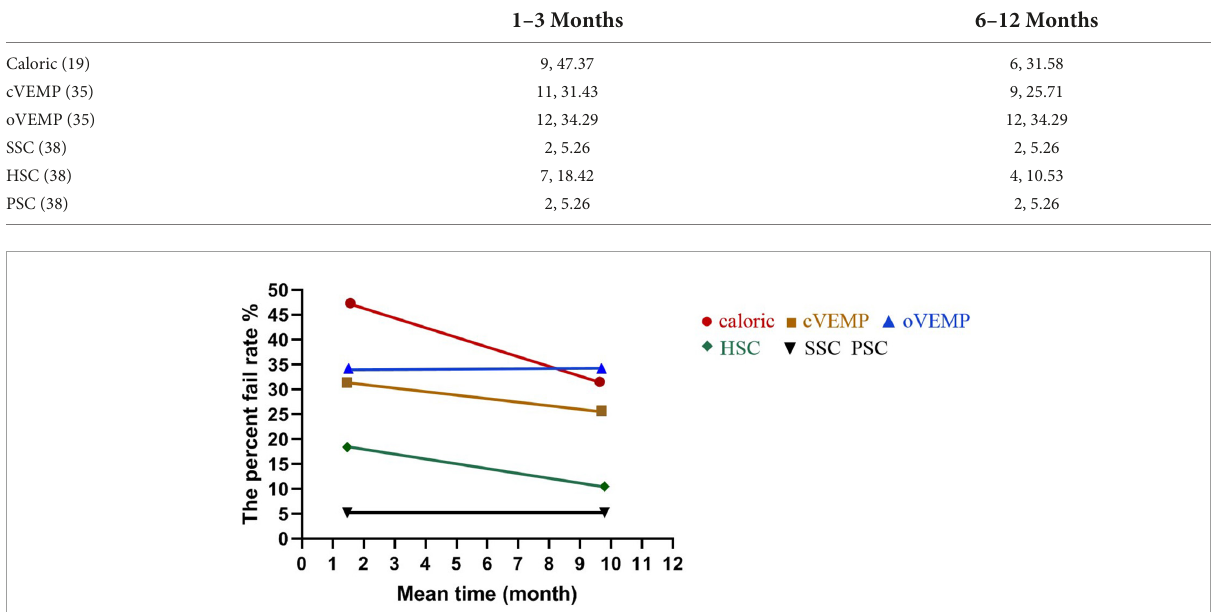
FIGURE3 The percent fail rate of each end-organ function on the implanted side at short and long follow-up times after surgery. The percent fail rates showed no significant differences from 1–3 (1.57 ± 0.90) to 6–12 (9.63 ± 2.36) months in caloric ( p = 0.319) and from 1–3 (1.47 ± 0.86) to 6–12 (9.79 ± 2.28) months in HSC tested by vHIT ( p = 0.328) post-operatively. There was no significant difference in cVEMP between 1–3 (1.46 ± 0.85) and 6–12 (9.69 ± 2.31) months ( p = 0.597). The percent fail rates of oVEMP were the same at 1–3 (1.51 ± 0.89) and 6–12 (9.69 ± 2.31) months ( p = 1.000). The percent fail rates of SSC and PSC were the same at 1–3 (1.47 ± 0.86) and 6–12 (9.79 ± 2.28) months ( p = 1.000,